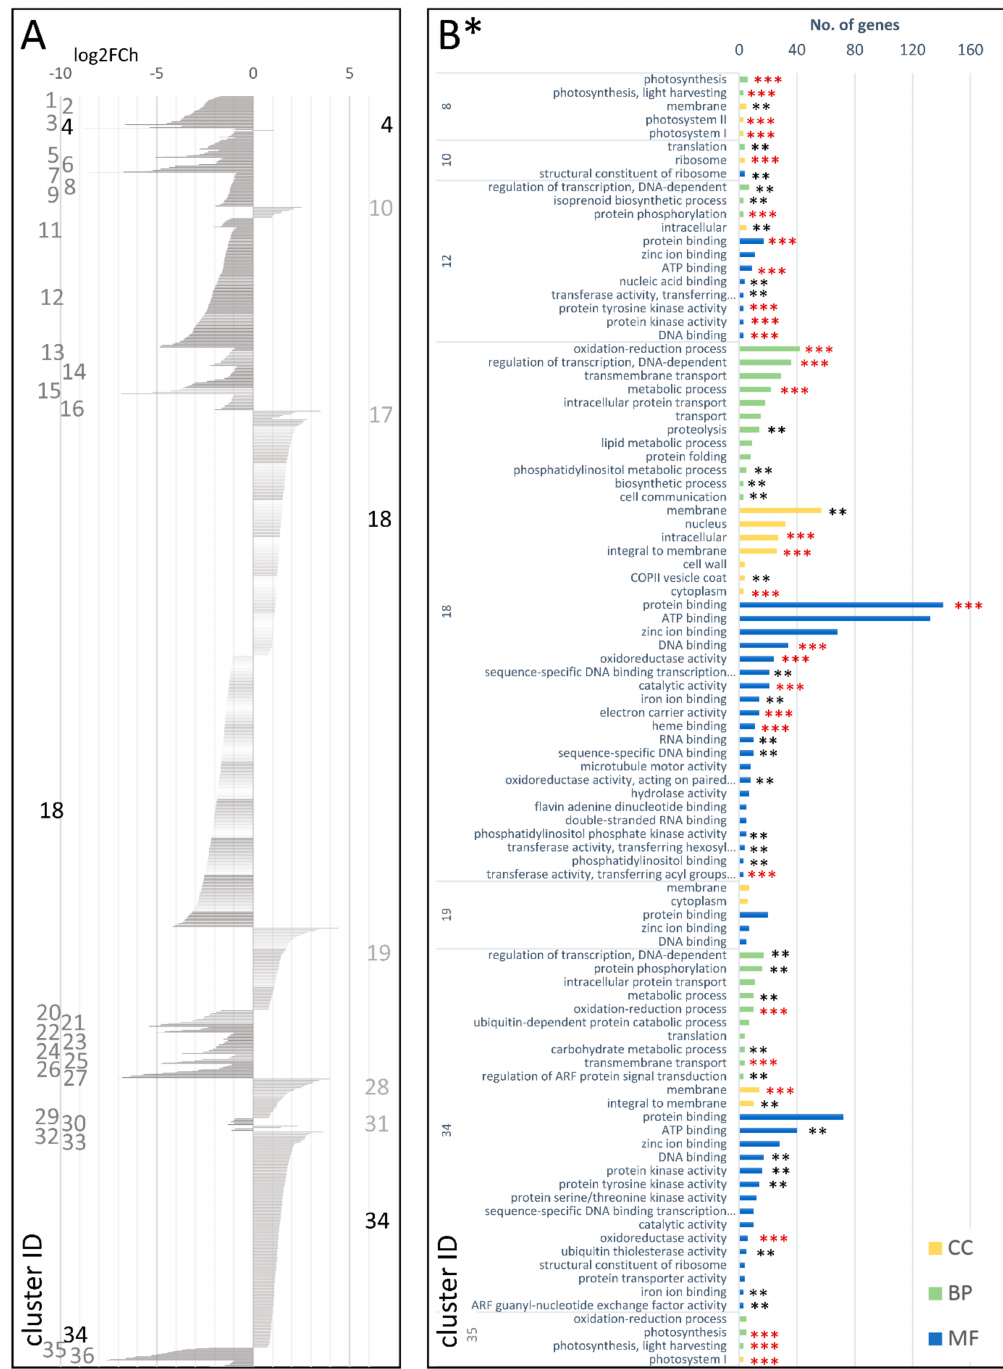
Figure 5. Clusters of DEGs in the cultivated carrot (young plant v. mature root; cDEG.1.3) showing log2FoldChange values ( A ) and GO enrichment results ( B ). Several clusters and enrichment terms in ( B ) were omitted for the clarity of presentation. CC—cellular component; BP—biological process MF—molecular function; *—number of genes in set >2; **—adjusted p -value < 0.01; and ***—adjusted p -value <